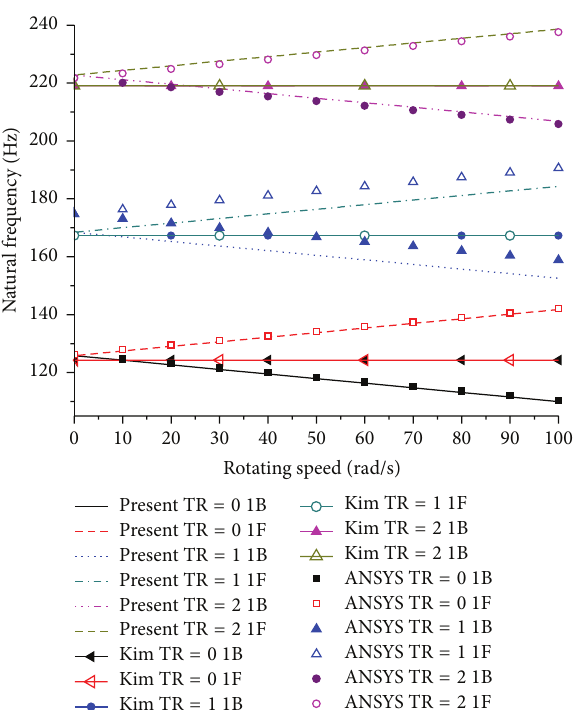
Figure 7: Changes comparison with rotating speed ( 𝜃 = 20 ∘ ).